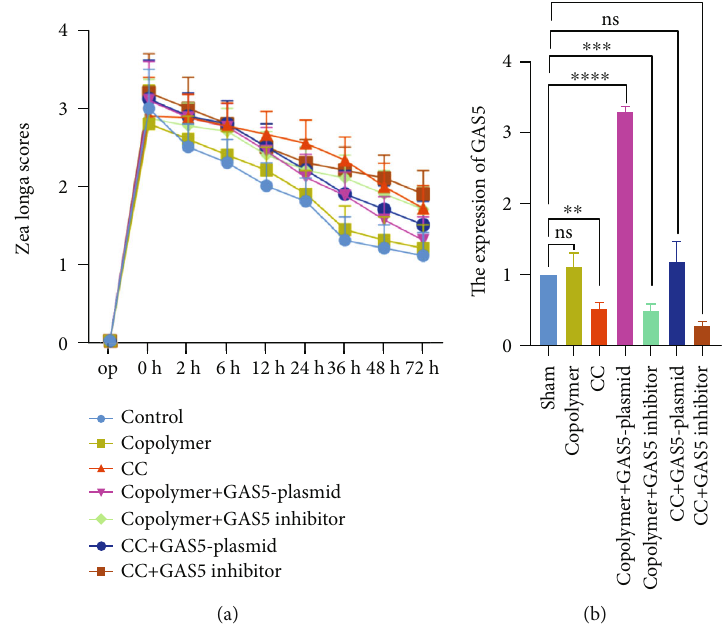
Figure 4: Animal modeling evaluation and lncRNA GAS5 detection. (a) Animal model scoring. (b) Detection of the expression of lncRNA GAS5 through RT-PCR ( ∗ P < 0 : 05 , ∗∗ P < 0 : 01 , ∗∗∗ P < 0 : 001 , and ∗∗∗∗ P < 0 : 0001 ; ns: not signi fi